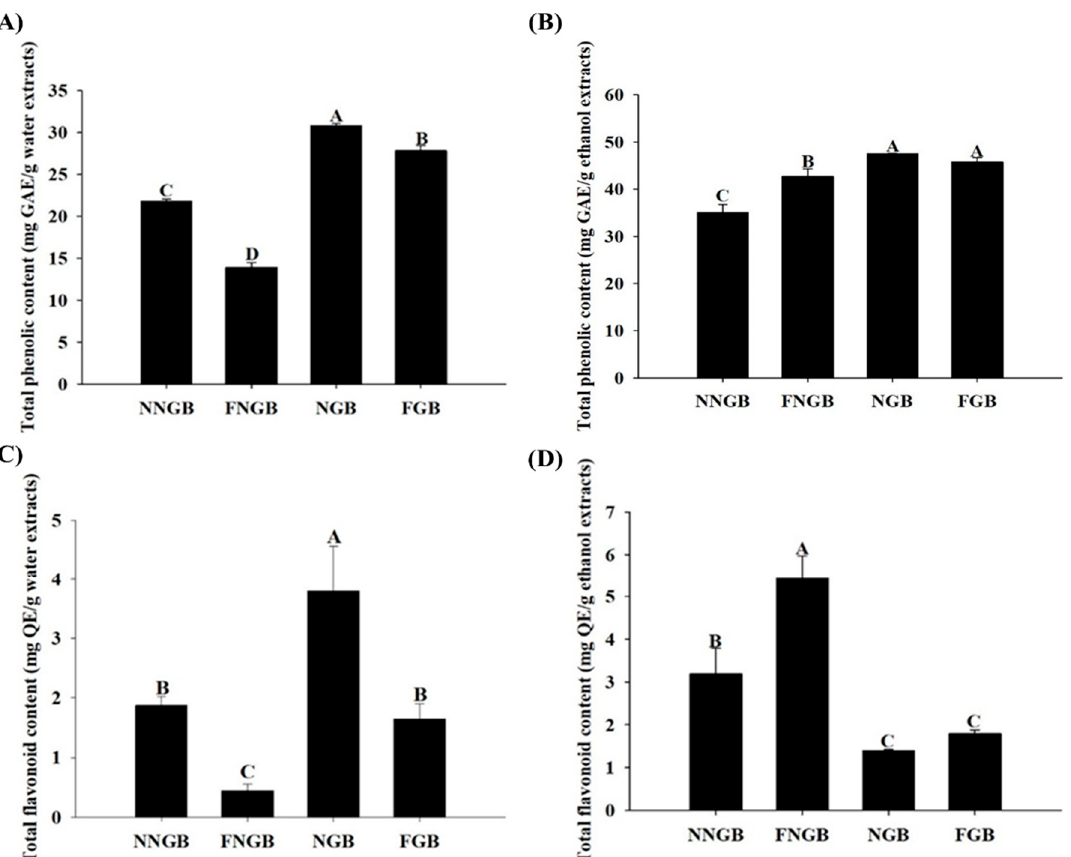
Figure 2. Total phenolic contents ( A , B ) and total flavonoid contents ( C , D ) in the water ( A , C ) and ethanol ( B , D ) extracts of nonfermented-nongermination black soy milk, fermented-nongermination black soy milk, nonfermented-germination black soy milk, and fermented-germination black soy milk. Data are presented as means ± SD ( n = 3). Values with different uppercase letters were significantly different based on Duncan’s multiple range test ( p < 0.05). NNGB, nonfermented-nongermination black soy milk; FNGB, fermented-nongermination black soy milk; NGB, nonfermented-germination black soy milk; FGB, fermented-germination black soy milk; GAE, gallic acid equivalent; QE, quercetin equivalent.